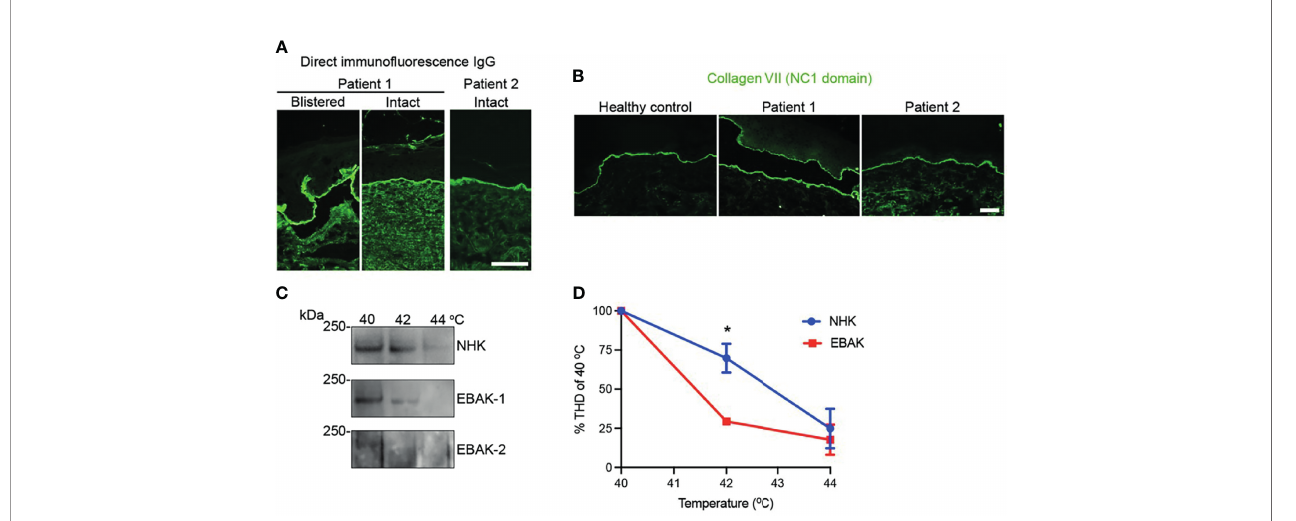
FIGURE 2 | Results of the diagnostic assessment. (A) Direct immuno fl uorescence with linear IgG along the DEJZ and (B) immuno fl uorescence mapping of patient 1 and 2 showing regular staining of collagen VII compared to healthy control. Collagen VII of patient 1 stains at dermal and epidermal side within the blister, reminiscent of an older blister. Collagen VII of patient 2 shows wider depositions at DEJZ and interruptions due to microblistering. (C) Immunoblot of the trypsine-digested collagen VII shows degradation at lower temperatures in the patients ’ keratinocyte lysates, as graphically depicted in (D) . * equals p: 0,0118 as tested with 2-WAY